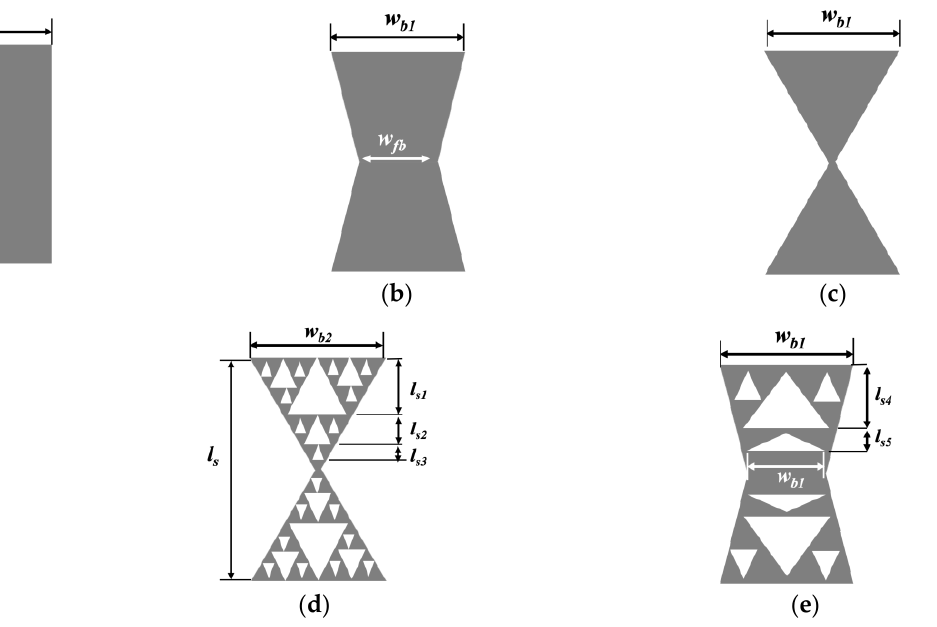
Figure 3. Different kinds of element antennas: ( a ) basic square patch; ( b ) fat bow tie patch; ( c ) bow tie patch; ( d ) bow tie Sierpinski fractal antenna; ( e ) fat bow tie Sierpinski fractal patch. Table 1. Types of antenna elements, their resonant frequencies, and corresponding wireless commu- nication